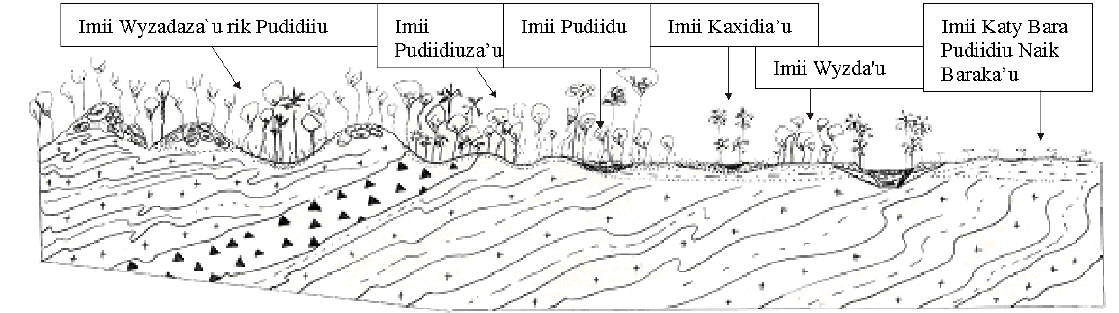
Figura 2. Diagrama esquemático de alguns dos solos presentes na TI Malacacheta, reconhecidos pelos índios